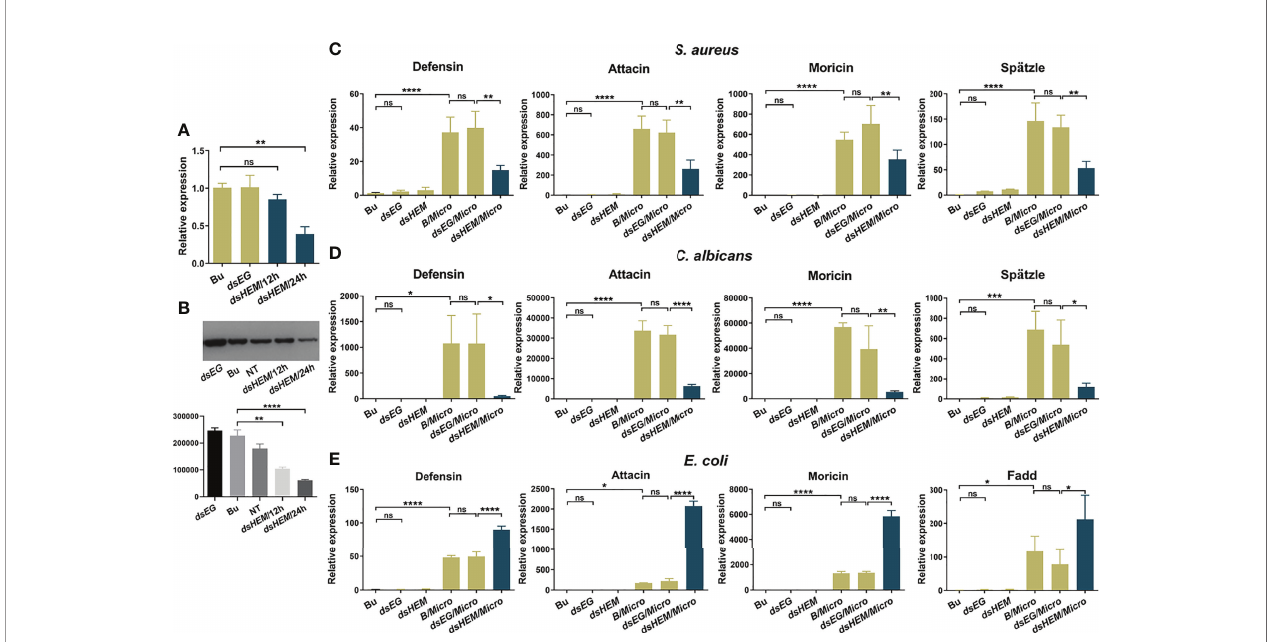
FIGURE 4 | Effect of hemolin on the induction of antibacterial peptide synthesis in ( A ) pernyi larvae by qPCR analysis. RNAi ef fi ciency within 24 hr post RNAi- treatment was estimation by qPCR (A) and western blotting analysis (B) . For qPCR, the whole body of larvae was collected at 12 and 24 hr post-injection with dshemolin ( dsHEM ) or dsEGFP ( dsEG ) double-stranded RNA. Larvae injected with buffer (Bu) were used as controls. For western blotting analysis, 10 m g of plasma samples from dshemolin -treated and control larvae were used. NT: native sample without treatment. The results represent 3 biological replicates and the gray-scale statistical was shown below. (C-E) Relative mRNA expression levels of antibacterial peptides and the representative factors in Toll or Imd signaling pathway in response to microbial stimulation. Micro: larvae collected 12 hr after injection with formaldehyde-killed microbial cells (10 5 cells per larva); dsEG / Micro : larvae were fi rst injected with dsEGFP for 24 hr and then immune-challenged with microbial cells for another 12 hr; dsHEM / Micro : larvae were fi rst injected with dshemolin for 24 hr and then immune-challenged with microbes for another 12 hr. Microbes: E. coli, S. aureus and C. albicans. The relative expression level of antibacterial peptides and signaling pathway related factors detected by qPCR: defensin, attacin, moricin, spätzle and Fadd. Each bar represents the mean ± SD (N=3). ****: p<0.0001, ns, no signi fi cant